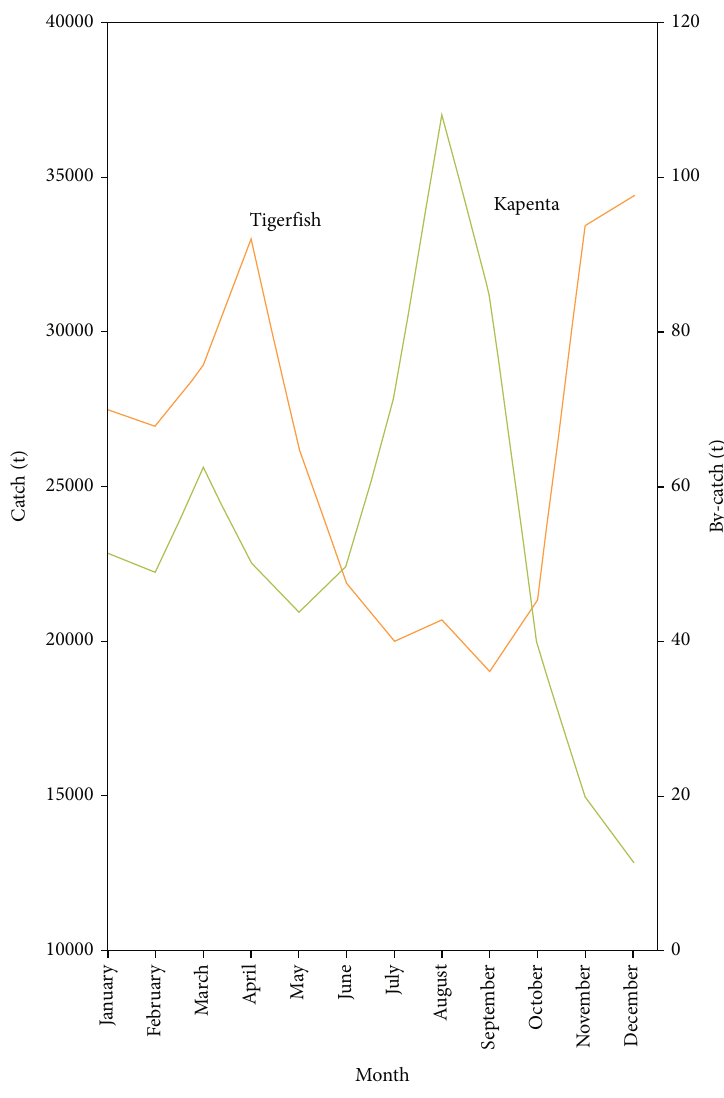
Figure 1: Time series plot of kapenta and tiger fi sh